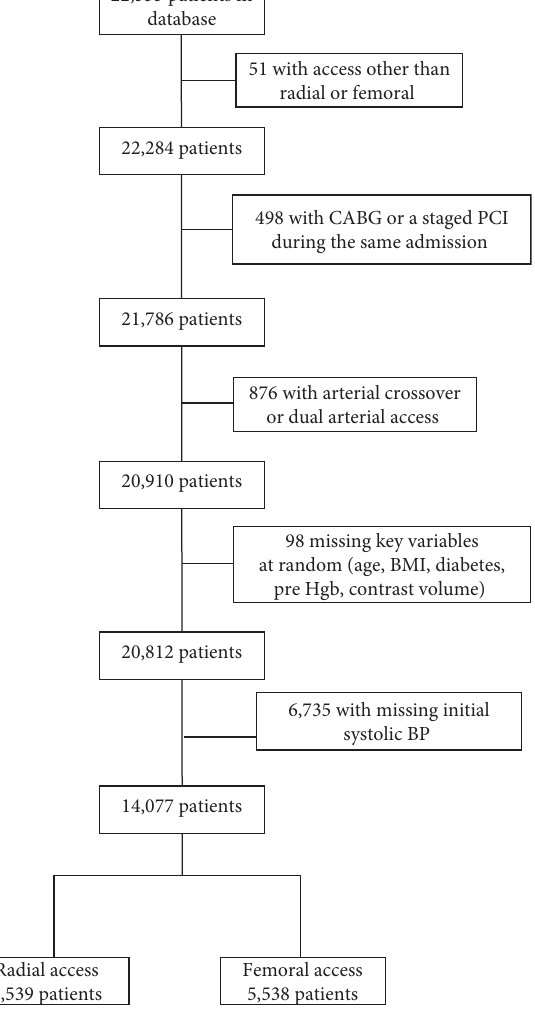
Figure 1: Flowchart of excluded patients. Legend: patient in- clusion/exclusions in the consolidated standards of reporting trials (CONSORT) format. Abbreviations: BMI � body mass index; BP � blood pressure; CABG � coronary artery bypass graft; Hgb � hemoglobin; PCI � percutaneous coronary